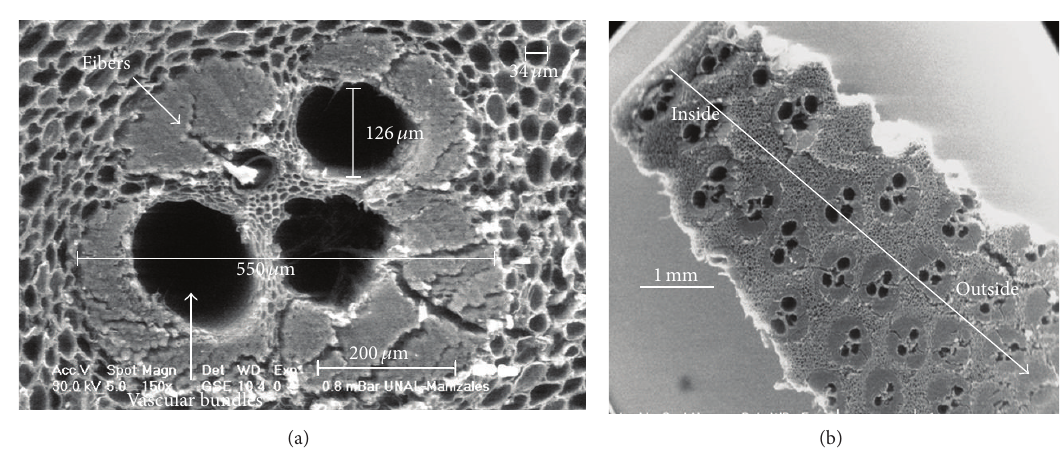
Figure 7: Micrographs of the GAKVB culm: (a) fibers and vascular bundles and (b) distribution of vascular